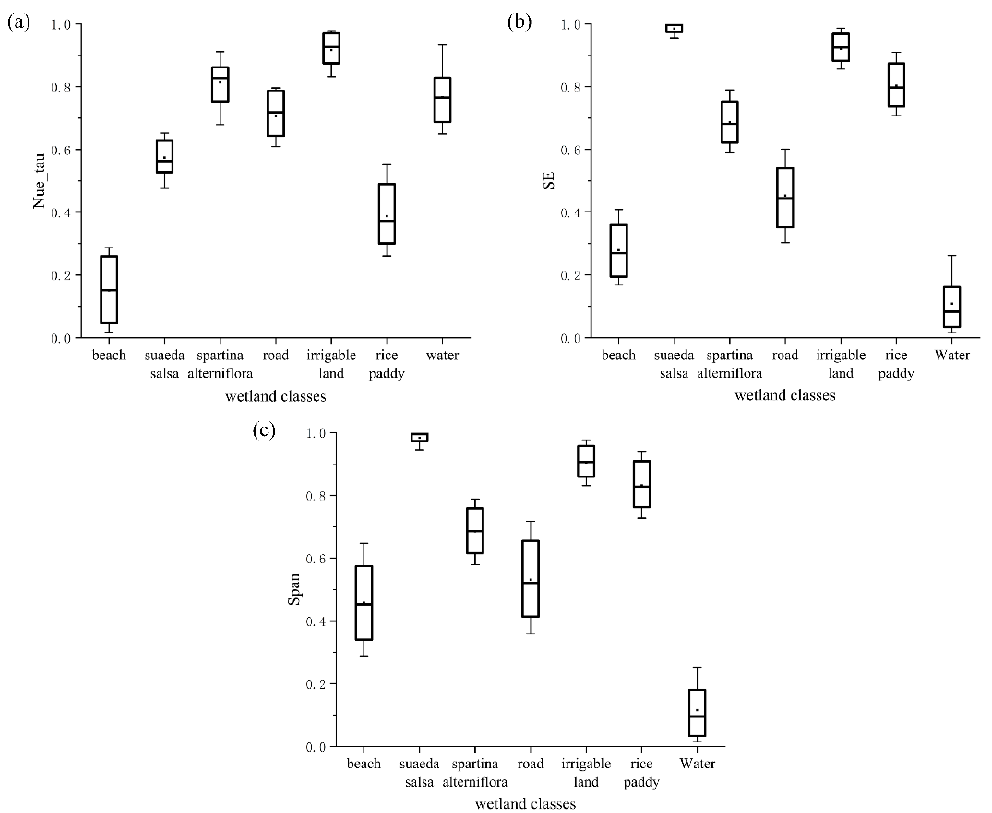
Figure 6. Boxplots of the features in different classes: ( a ) the distribution of Neu_tau among different classes; ( b ) the distribution of SE among different classes; and ( c ) the distribution of Span among different classes.